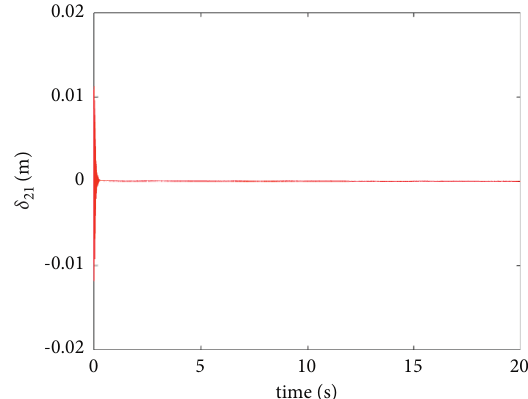
Figure 10: The deformation variable δ